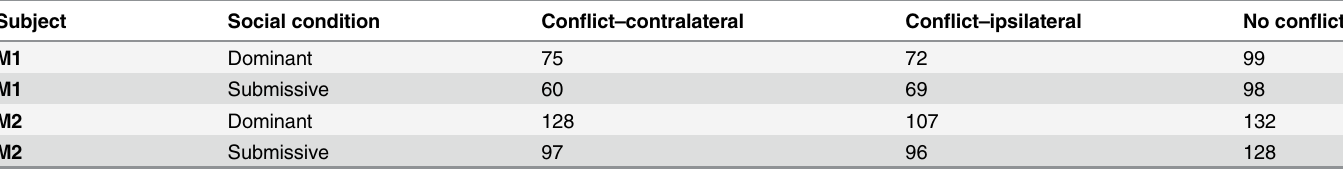
Table 1. Number of trials in each social condition.